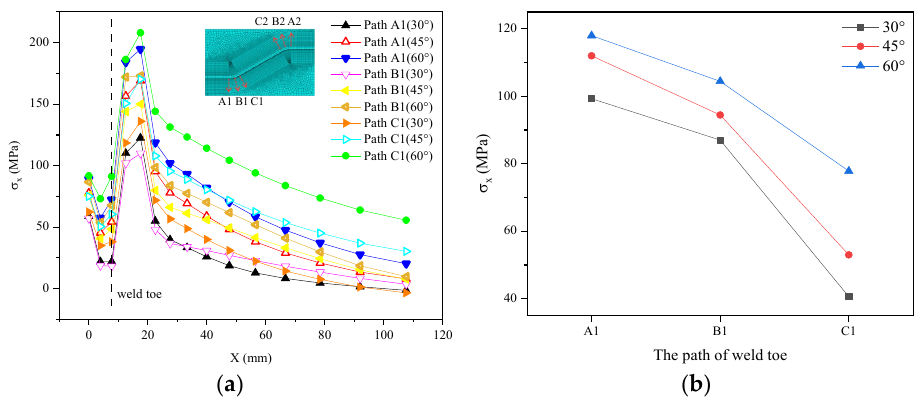
Figure 19. Residual stress distribution of transverse path posterior weldment. ( a ) Along the path direction; ( b ) Position of weld toe.